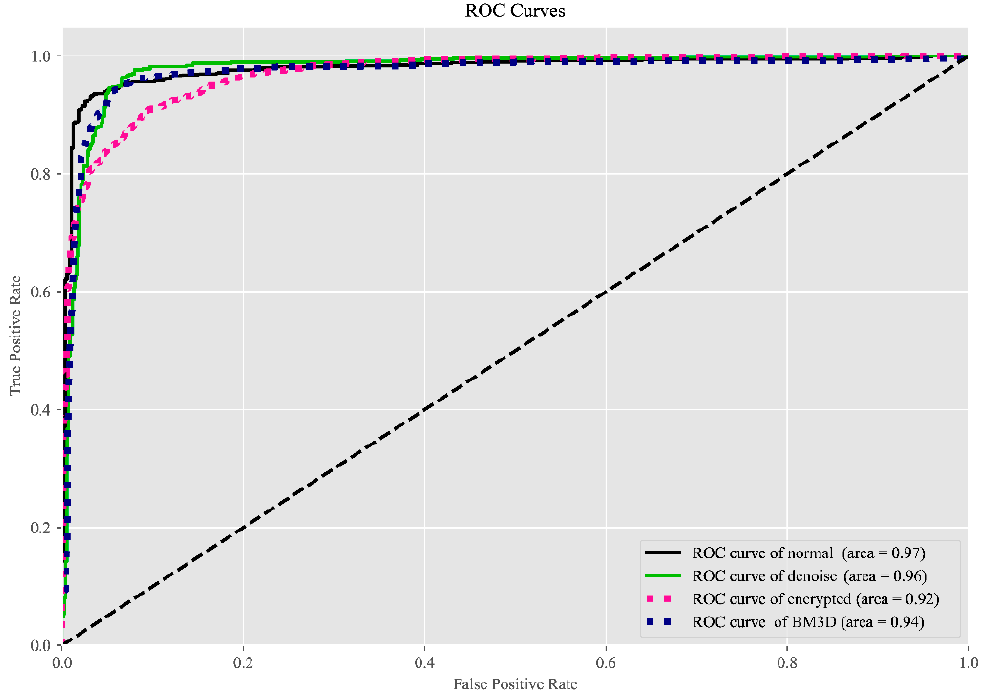
Figure 5. The recognition performance of different neural network models on the UCMerced da- taset.